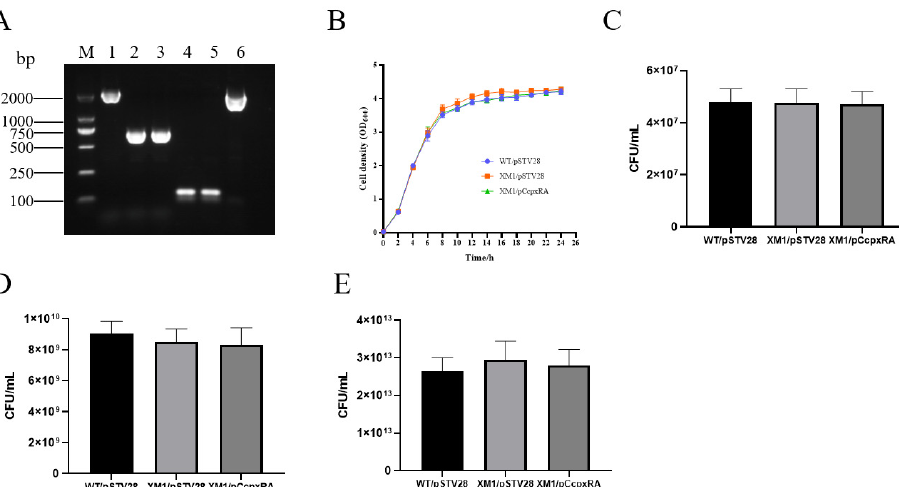
Figure 1. PCR identification and growth curve assays of WT, cpxRA mutant, and complementary strains. ( A ) Molecular identification of WT/pSTV28, XM1/pSTV28, XM1/pC cpxRA strains. M: 2000 bp marker, lanes 1–3 for the identification of cpxRA gene using primers Check- cpxRA -out-f/Check- cpxRA -out-r, lanes 4–6 for the identification of pSTV28 plasmid and complement plasmid pC cpxRA using primers M13-f/M13-r. ( B ) Growth curves of WT/pSTV28, XM1/pSTV28, XM1/pC cpxRA strains. ( C – E ) The number of colonies in culture medium at 2 h, 4 h, and 10 h,